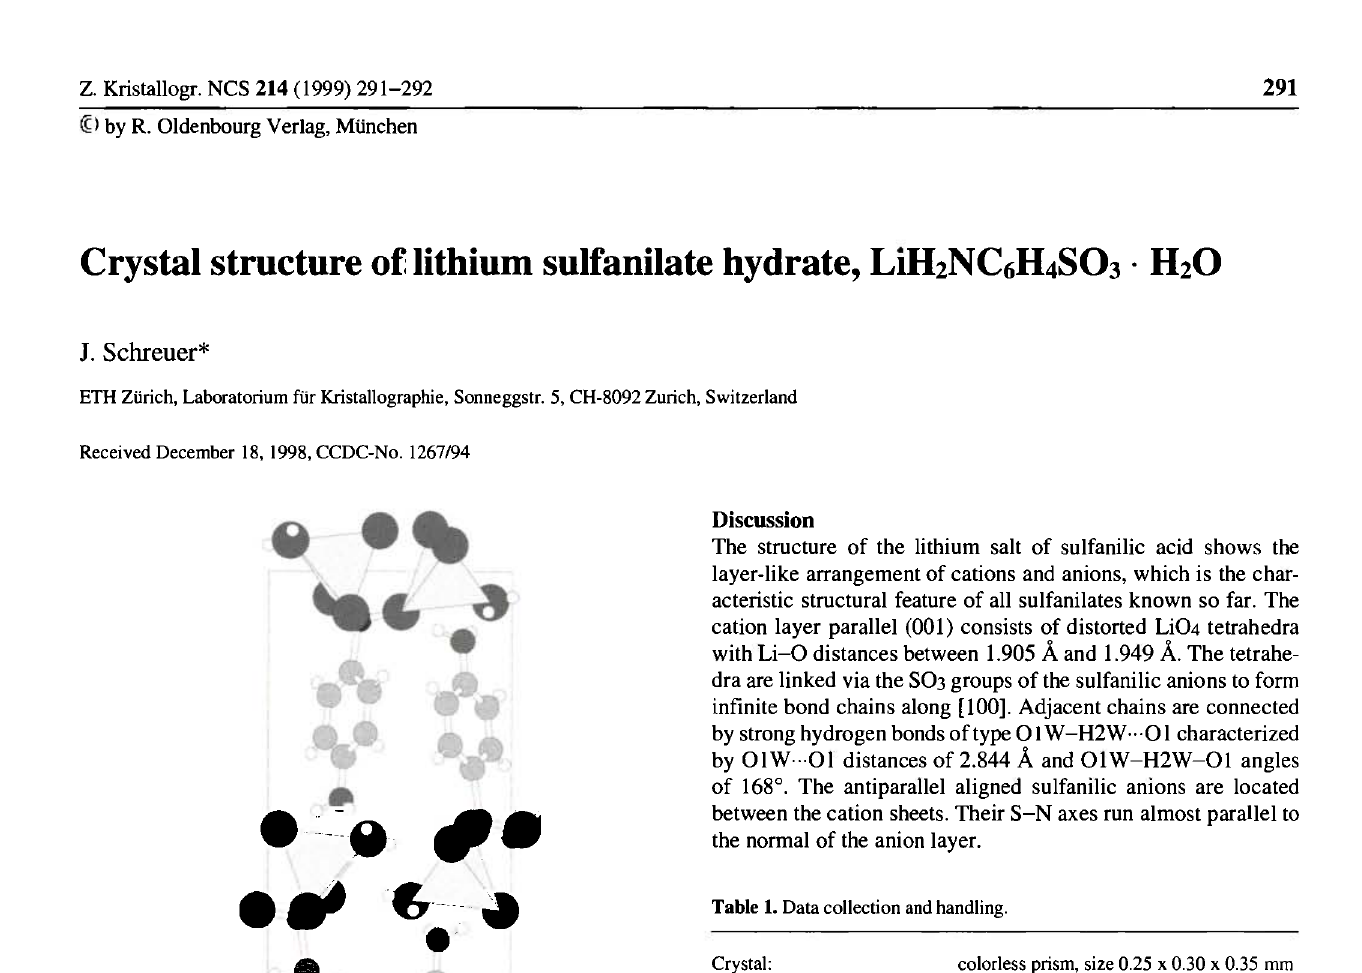
Table 2. Atomic coordinates and displacement parameters (in A 2